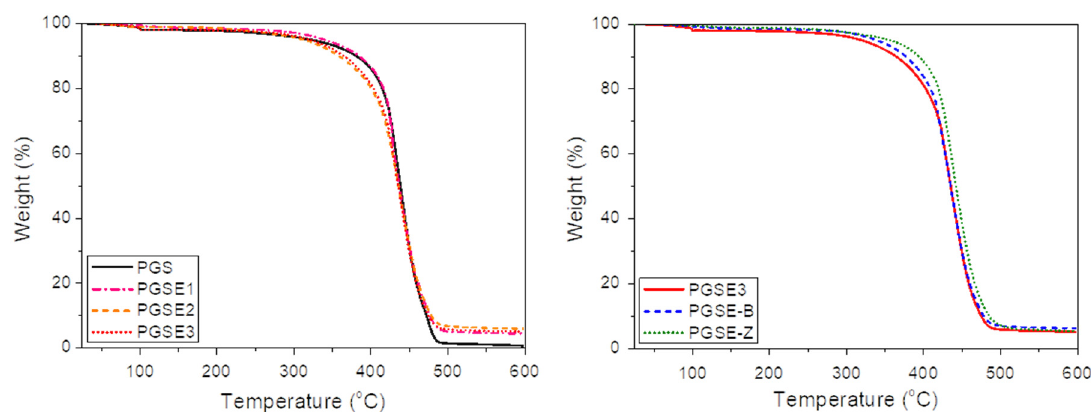
Figure 4. TGA curves of PGS, PGSE1, PGSE2, PGSE3, PGSE-B, and PGSE-Z.